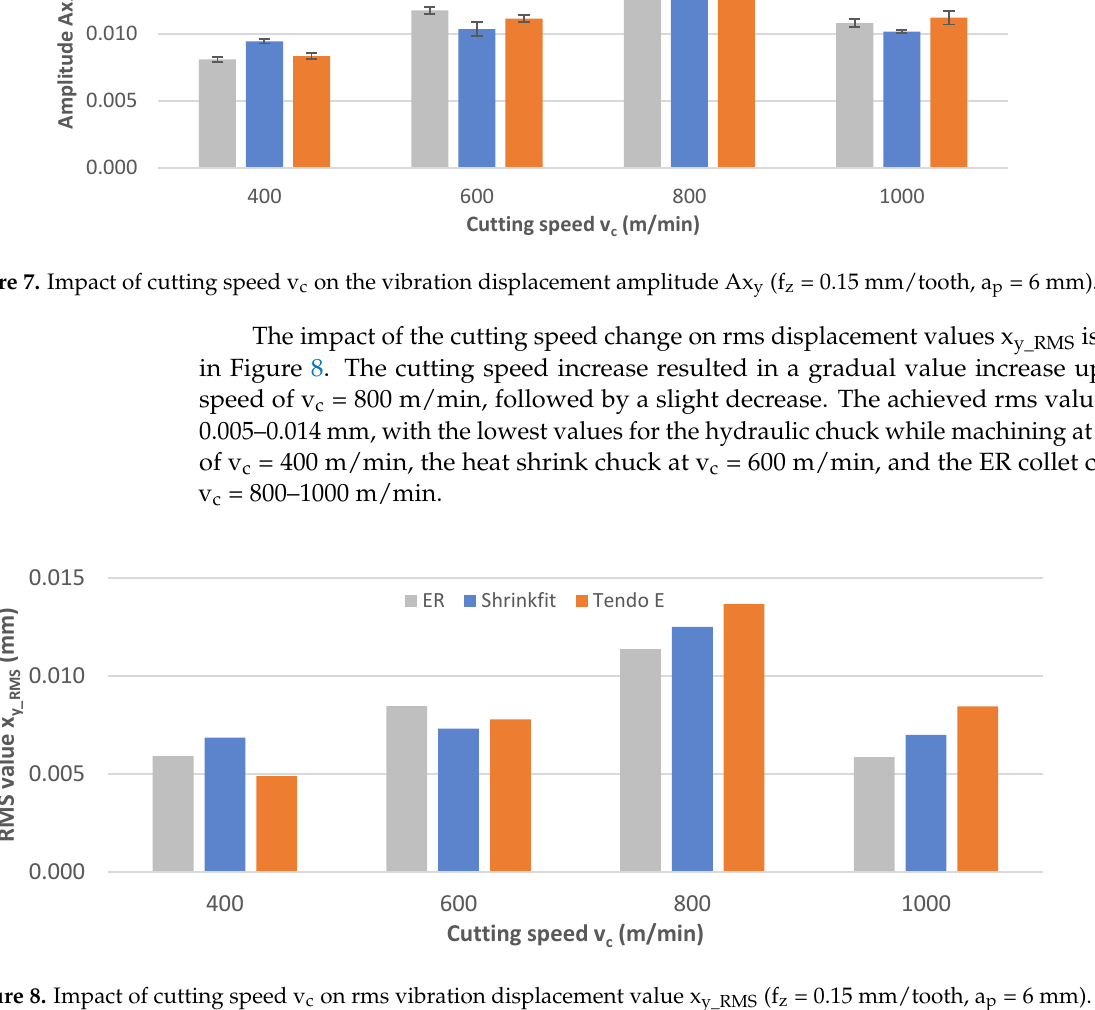
Figure 9. Impact of feed per tooth f z on maximum vibration displacement value x y (v c = 800 m/min, a p = 6 mm). Increasing the feed per tooth to f z = 0.10 mm/tooth resulted in a vibration displace- ment value decrease, while further ranges were associated with a continuous increase. While carrying out the milling process, the recorded values were 0.014 – 0.042 mm, with the lowest feed per tooth values of f z = 0.15 – 0.30 mm/tooth for the ER collet chuck, f z = 0.05 mm/tooth for the heat shrink chuck, and f z = 0.10 mm/tooth for the Tendo E hydraulic chuck. Figure 10 shows the impact of the feed per tooth change on the vibration displace- ment amplitude Ax y . In the course of machining, the recorded amplitude values were 0.007 – 0.022 mm, with the lowest values recorded mostly for the ER collet chuck at f z = 0.15 – 0.30 mm/tooth. Increasing the feed per tooth resulted in an initial reduction in the value (f z = 0.10 mm/tooth) followed by an increase in amplitude; however, a decrease also occurred for the tooth feed per tooth value of f z = 0.20 mm/tooth.